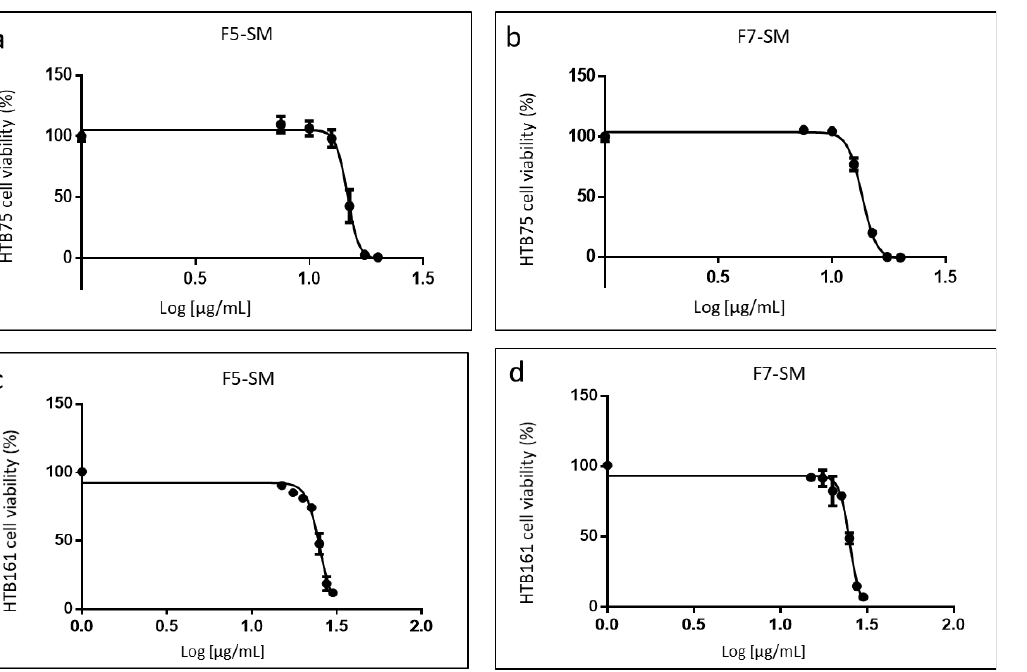
Figure 3. Cell viability of HTB75 ( a , b ) and HTB161 ( c , d ) cells following treatment with F5-SM and F7-SM at different concentrations for IC50 values at 48 h calculation from 5P logistic curve fit using GraphPad Prism version 6.1. Concentration 0 was the vehicle-treated control (2.50% and 3.50% v/v methanol for HTB75 and HTB161 respectively). Error bars indicate ± SE ( n = 3).